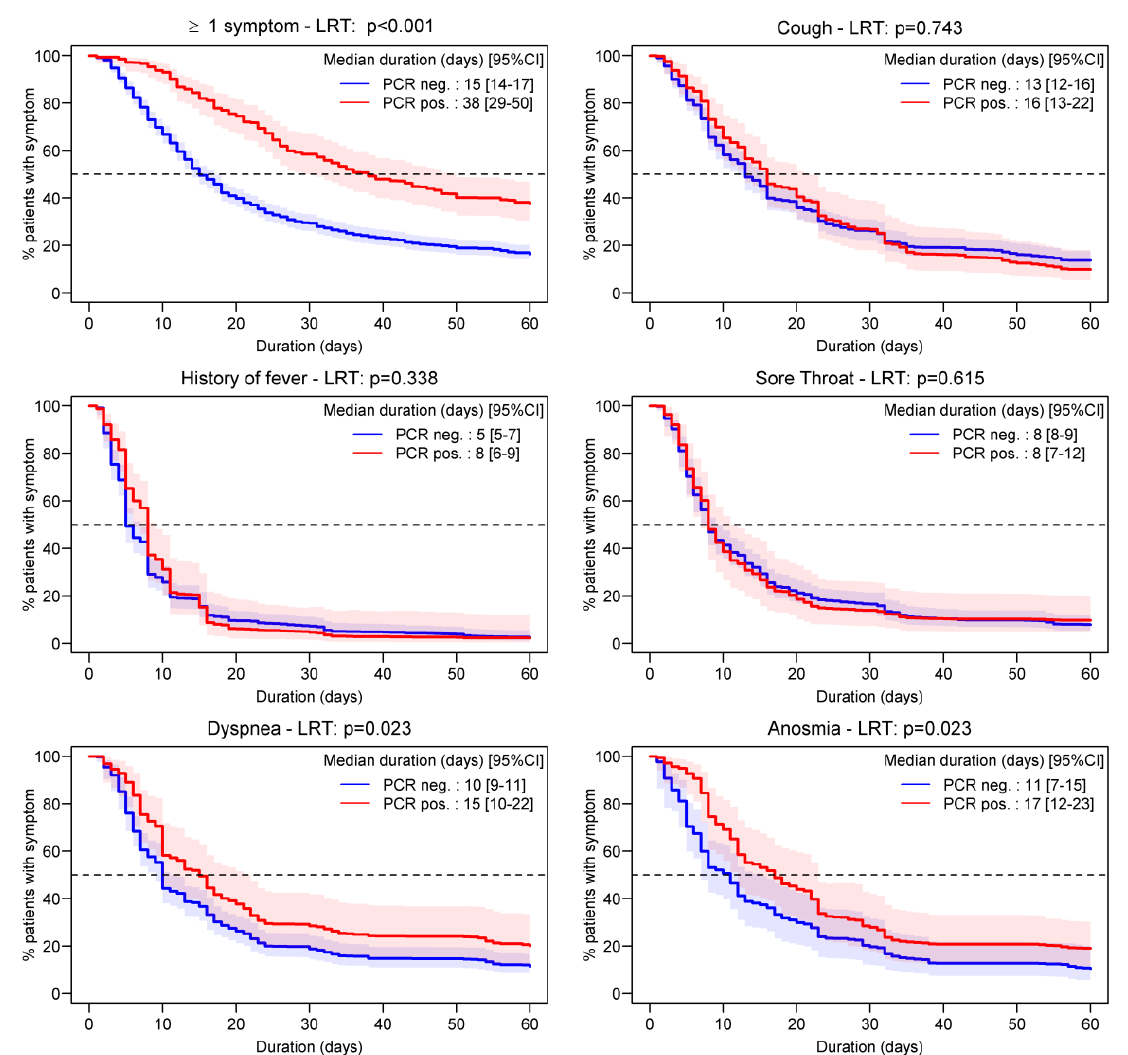
Figure 3. Pooled daily Kaplan – Meier estimates (with 95% confidence intervals) stratified by PCR